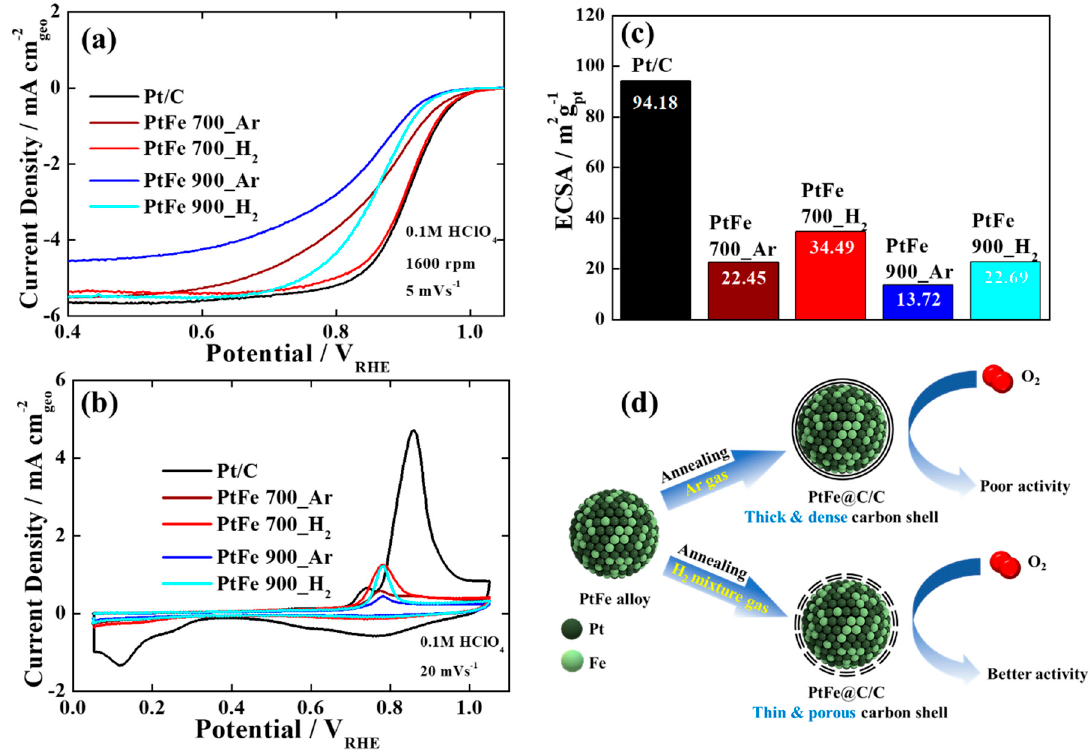
Figure 3. ( a ) oxygen reduction reaction (ORR) polarization curves, ( b ) CO stripping curves, and ( c ) electrochemcial surface area (ECSA) values of commercial Pt/C and heat-treated PtFe catalysts. ( d ) Illustration of the formation mechanism of carbon shell-coated PtFe catalysts and the difference in their ORR activities depending on the carbon shell structure.